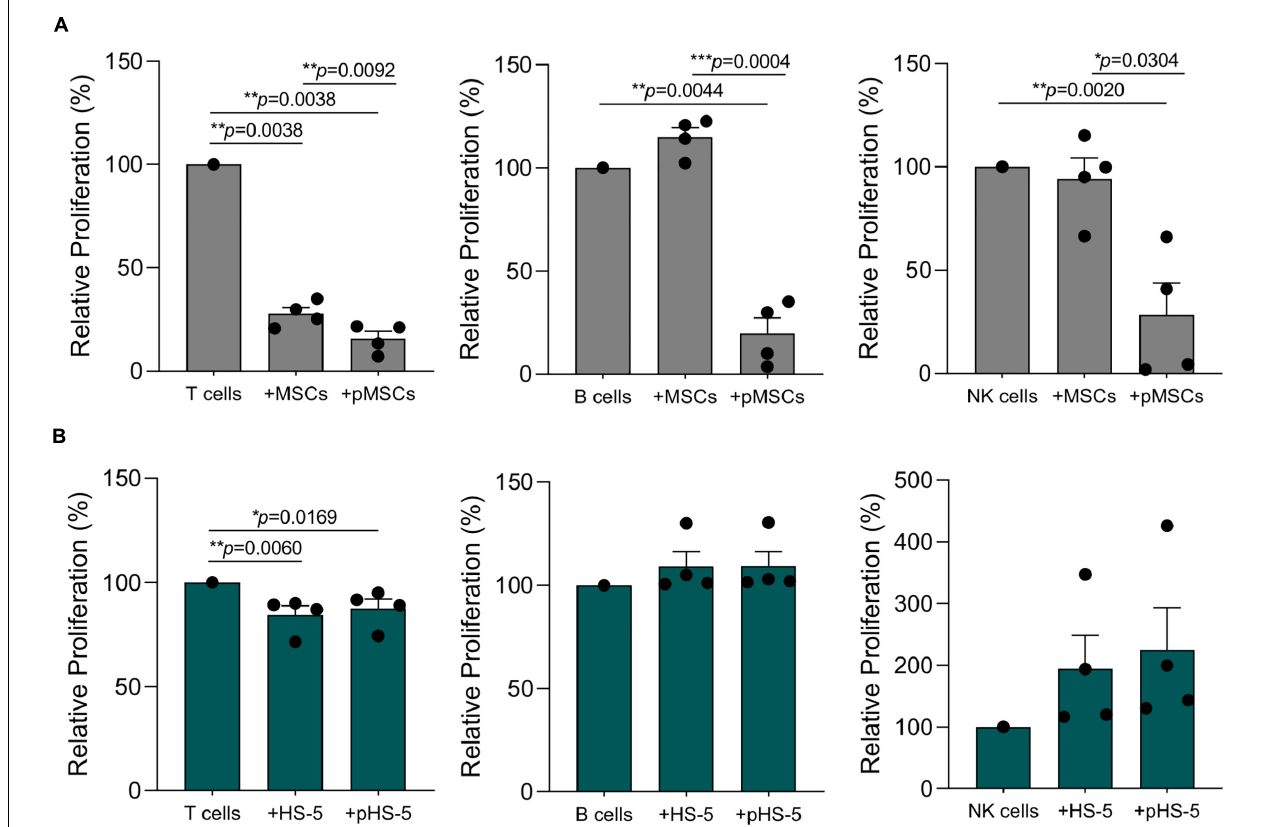
FIGURE 6 | HS-5 cell line immunosuppressive activity on T, B, and NK proliferation in resting and primed condition. (A,B) Relative T, B, and NK proliferation following the co-culture with resting or primed MSCs (gray) and HS-5 (green), respectively. Cell proliferation was calculated on living CD45 + cells according to CFSE dilution method by measuring CFSE gMFI and normalized on activated IECs cultured in absence of stromal cells. Data are represented as mean ±